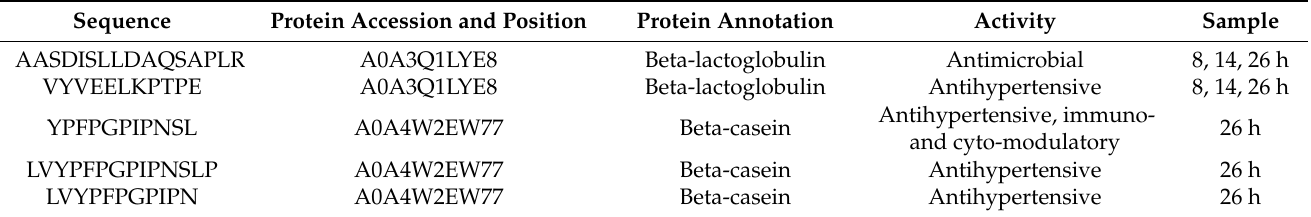
Table 3. Identified peptides that exactly matched in sequence and length to entries in the Biopep